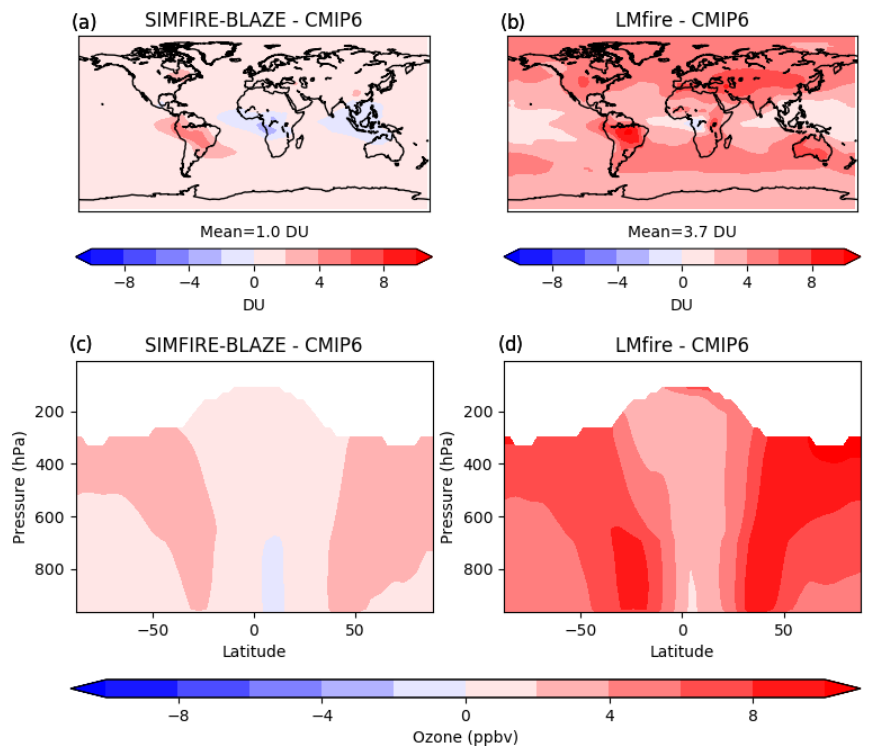
Figure 5. Difference in simulated PI O 3 between the CMIP6 control and the revised inventories SIMFIRE-BLAZE and LMfire. (a, b) A comparison of differences in tropospheric column O 3 in DU; (c, d) differences in zonal mean vertical O 3